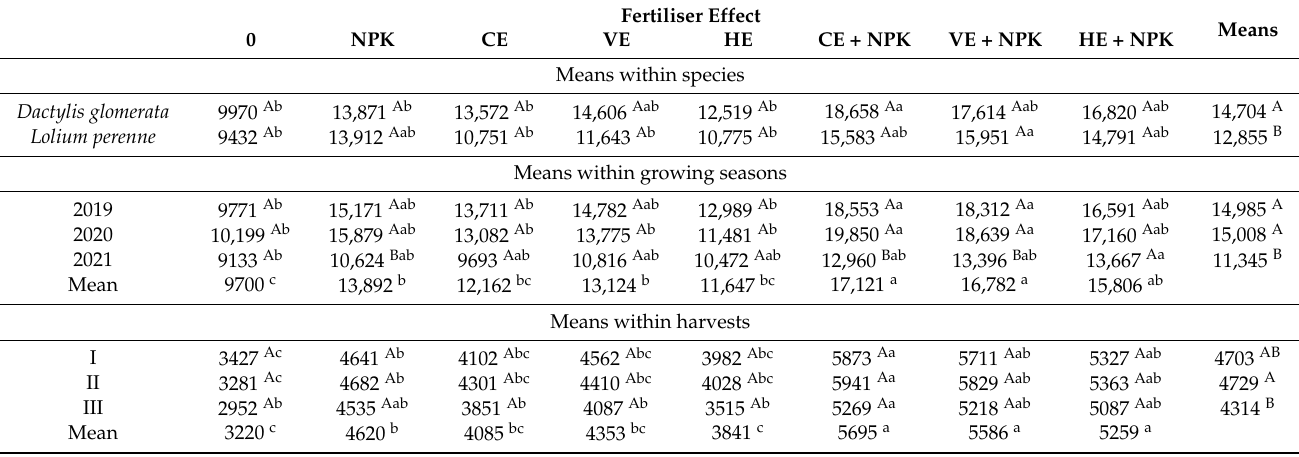
Table 5. The effect of different treatments on the annual energy yield of Dactylis glomerata and Lolium perenne (JP ha − 1